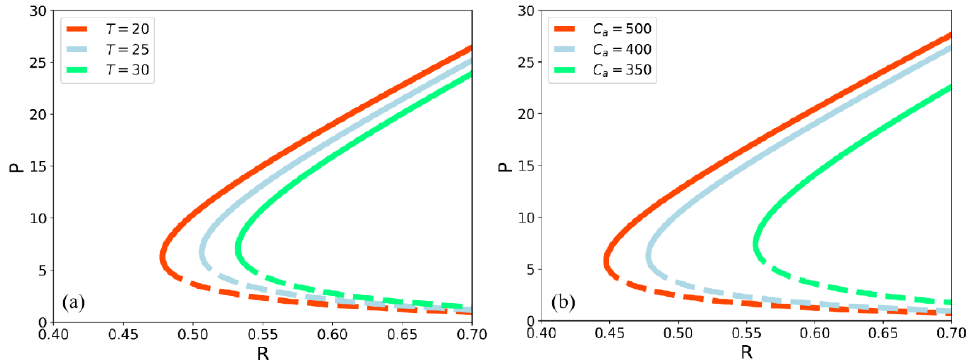
Figure 4. The sensitivity analysis of system (9). When the precipitation decreased, the system would change from a stable state (solid lines) to an unstable state (dotted lines). ( a ) Sensitivity analysis of the temperature k 1 = 5, k 2 = 5, and C a = 400. ( b ) Sensitivity analysis of [ CO 2 ] , k 1 = 5, k 2 = 5, and T = 25. Other parameters can be found in Appendix